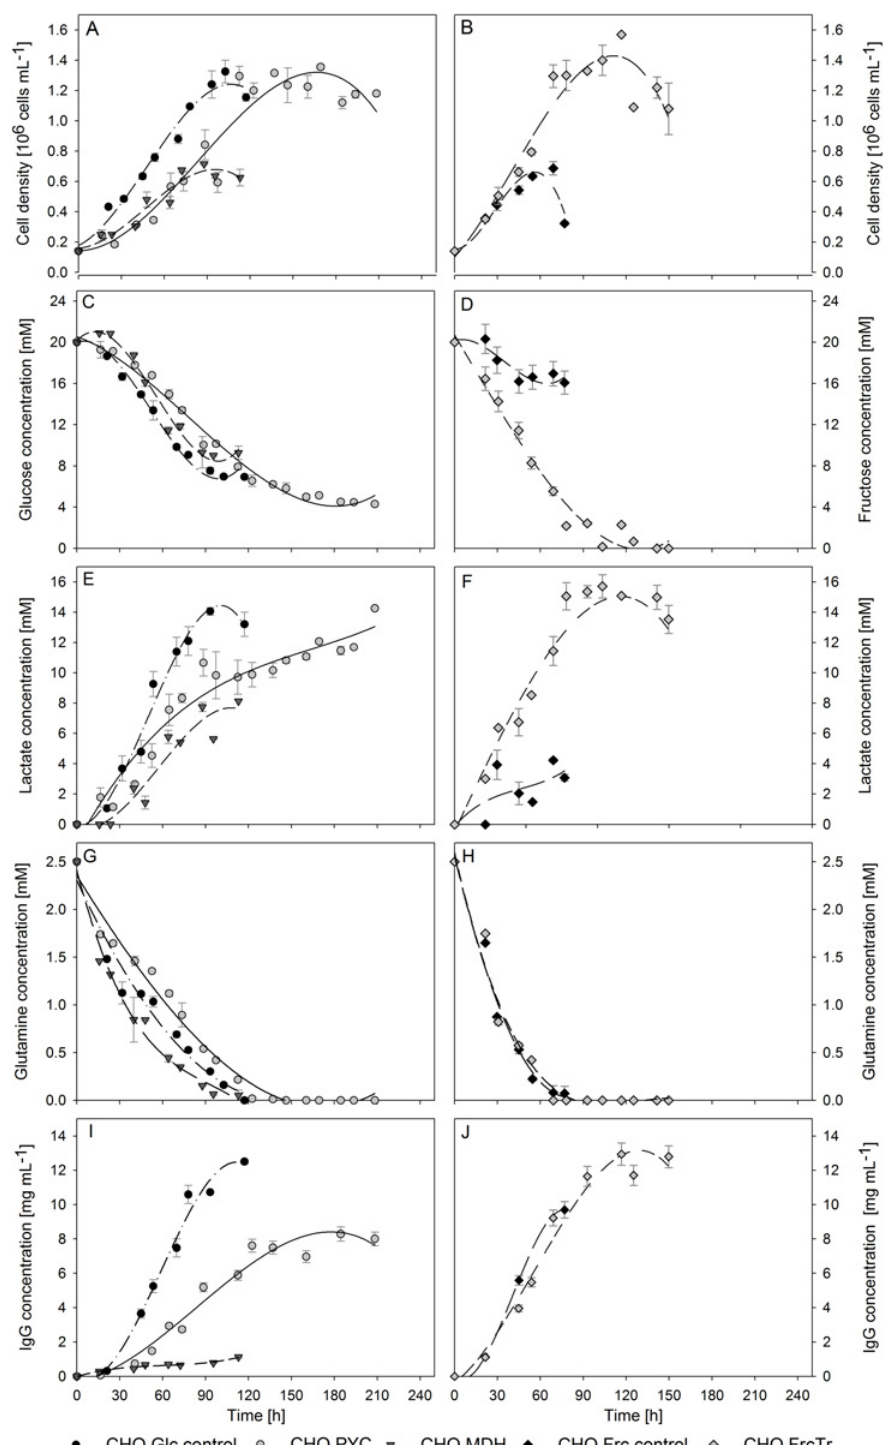
Fig 1. Batch cultures of different CHO cell engineered clones as a function of time. Graphs to the left describe cultures that use glucose as the main carbon source and graphs to right depicts cultures that use fructose as their main carbon source. ( ● ) CHO Glc control; ( ● ) CHO PYC; ( ▼ ) CHO MDH; ( ♦ ) CHO Frc control; ( ♦ ) CHO FrcTr. A, B: Viable cells; C, D: main carbon source concentration; E, F: lactate concentration; G, H: glutamine concentration; I, J: IgG